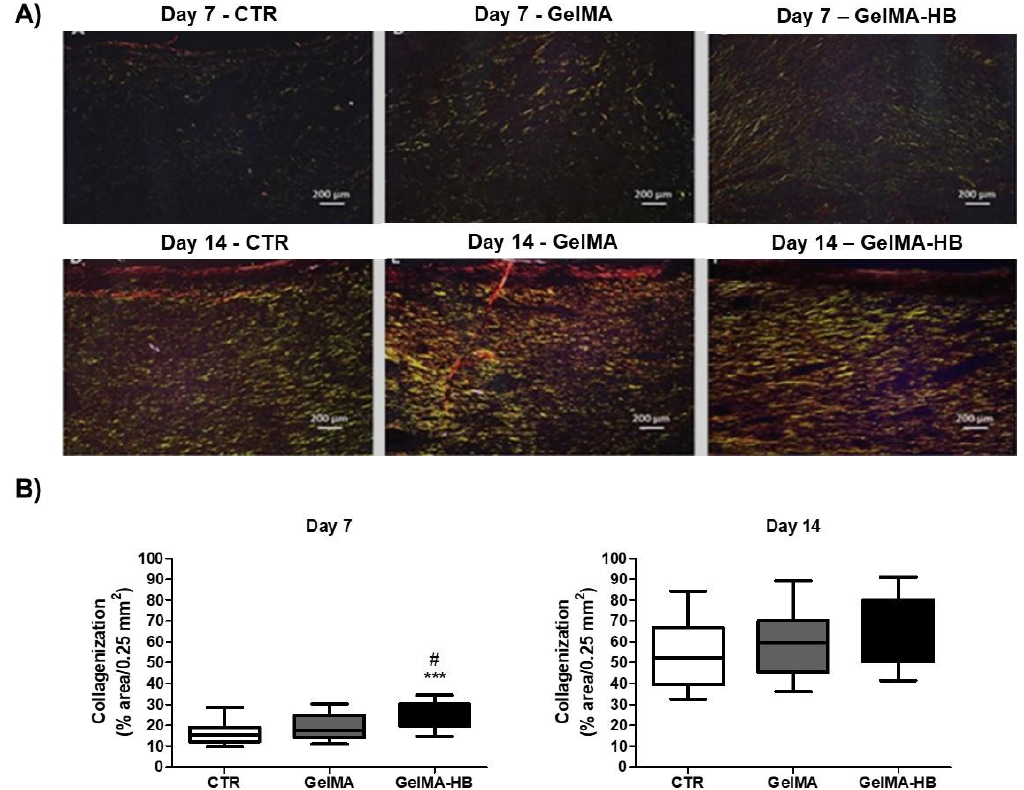
Figure 7. ( A ) Histological sections showing the collagenization pattern in the experimental groups. Few short, thin, delicate collagen fibrils, with reticular arrangement and greenish birefringence (type III collagen) are seen on day 7. Interfibrillar spaces are narrower in GelMA-HB than in the other groups. On day 14, collagen fibers are thicker, longer, and parallel-arranged, with yellow birefringence (type I collagen). ( B ) Histological assessment of the collagenization percentage (%) of the wounds over 7 and 14 days. CTR (untreated control); GelMA (wounds filled with GelMA); GelMA-HB (wounds filled with GelMA containing 2% ethanolic extract of H. bracteatus ). Significant differences compared to CTR are expressed as *** p < 0.001; significant differences in relation to GeLMA are expressed as # p < 0.05 (Kruskal–Wallis, followed by Dunn’s multiple comparisons